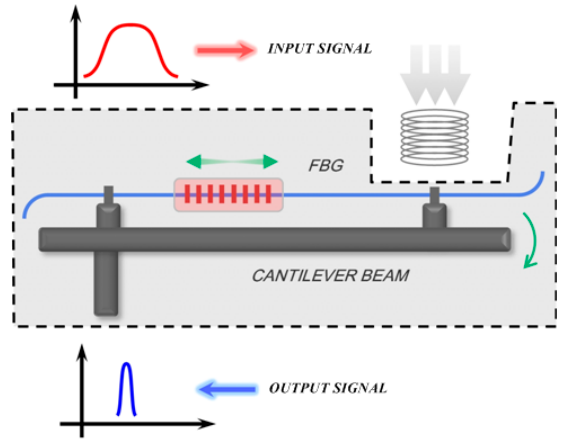
Figure 9. Schematic diagram of FBG pressure sensor.